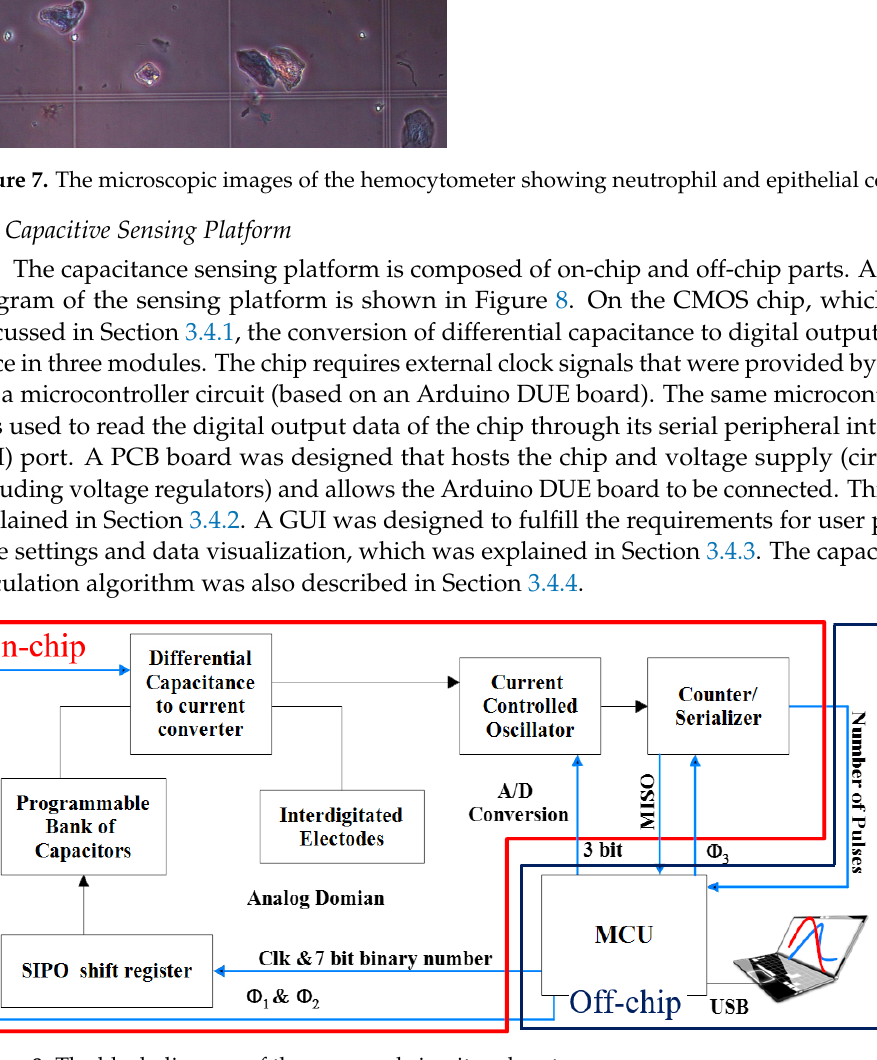
Figure 8. The block diagram of the proposed circuit and system.